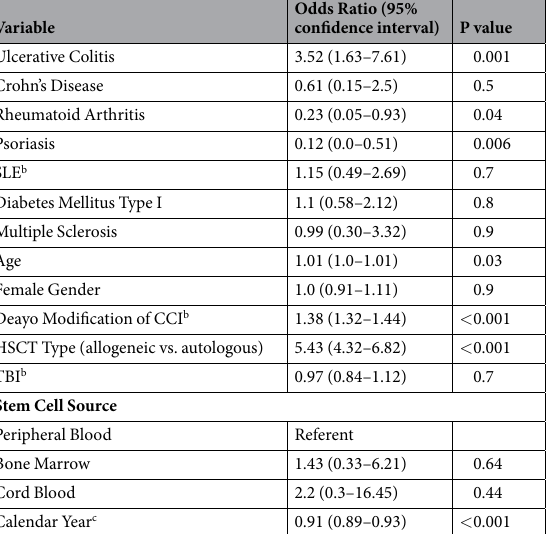
Table 4. Multivariate Predictors of In-hospital Mortality in Patients Receiving HSCT a (n = 36,018, weighted n = 181,428). a Above model was also adjusted for interaction between source of stem cell and calendar year. The interaction term was statistically insignificant (p = 0.37). If by adding the interaction term, the main effect did not change more than 10%, it was removed from the final model. Effect of hospital region, teaching status, location and bed size were insignificant. So, they were removed from the final model. b Abbreviations: CCI, Charlson Co-morbidity Index; TBI, Total Body Radiation; SLE, Systemic Lupus Erythematosus; HSCT, Hematopoietic Stem Cell Transplantation. c Calendar year was calculated as years since 1957 (year of first HSCT) - e.g. year 2011 was treated as year